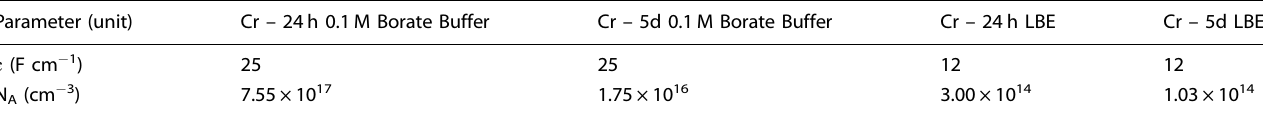
Table 3. Dielectric constants and Ionic acceptor densities (N A ) calculated for the 24 h and 5 day air oxidized Cr in 0.1 M borate buffer and LBE electrolyte. Parameter